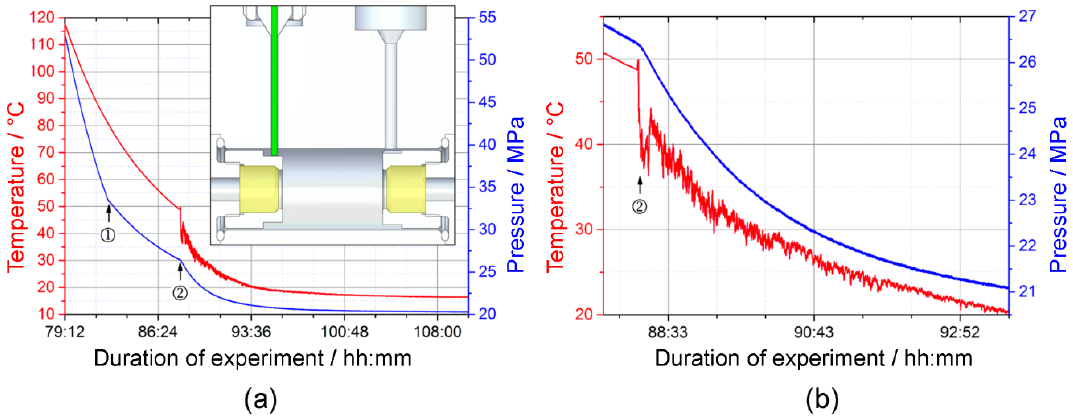
Figure 11. Internal temperature and pressure over time in the cool-down part of a solubility experiment using an optical cell as described in [19,20,41]; ( a ) Overview; the geometry of the reaction chamber and the position of measurement (at the tip of the thermocouple shown in green) are illustrated in the inset. Event ① most likely represents the phase transition of the NH 3 -N 2 -H 2 mixture from supercritical to subcritical state; ( b ) Close-up showing event ② , which corresponds to a change in thermal boundary conditions due to removal of the heating sleeve. Reprinted from [21].